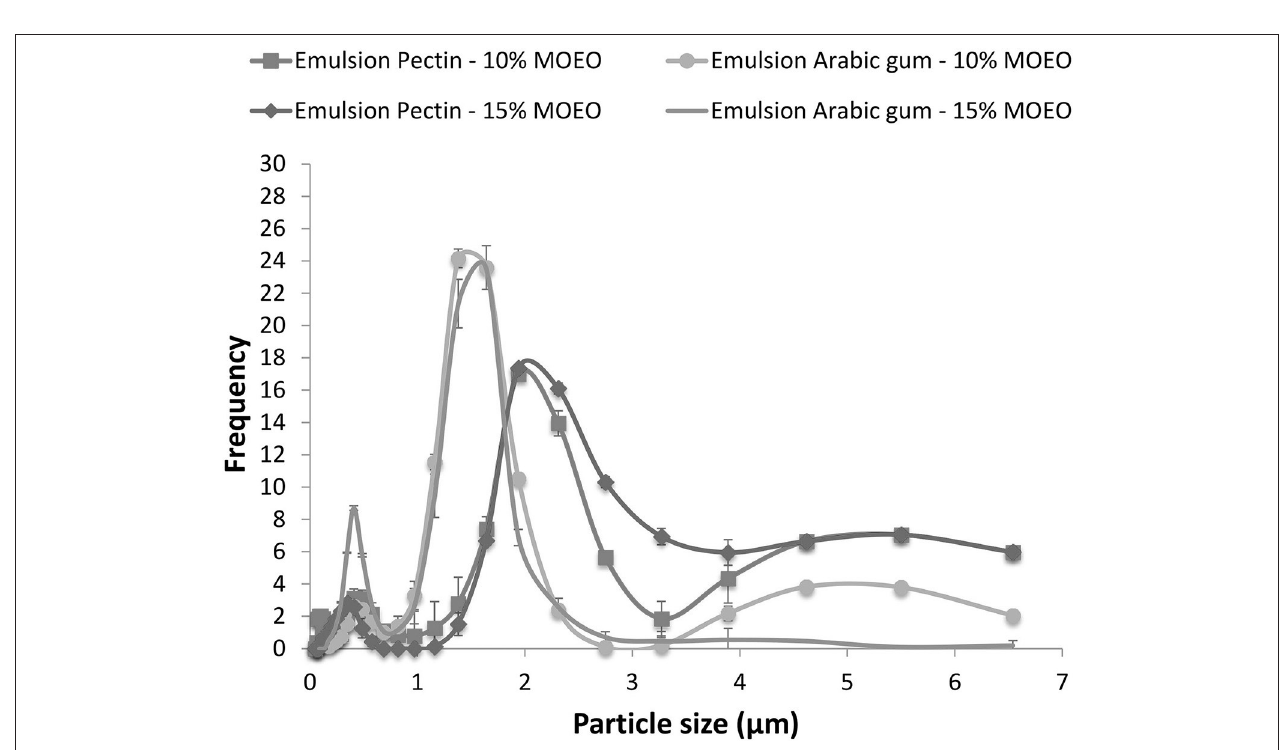
FIGURE 2 | Particle size distribution of different emulsion systems using pectin or Arabic gum with 10 and 15% w/w of Mexican oregano essential oil (MOEO).